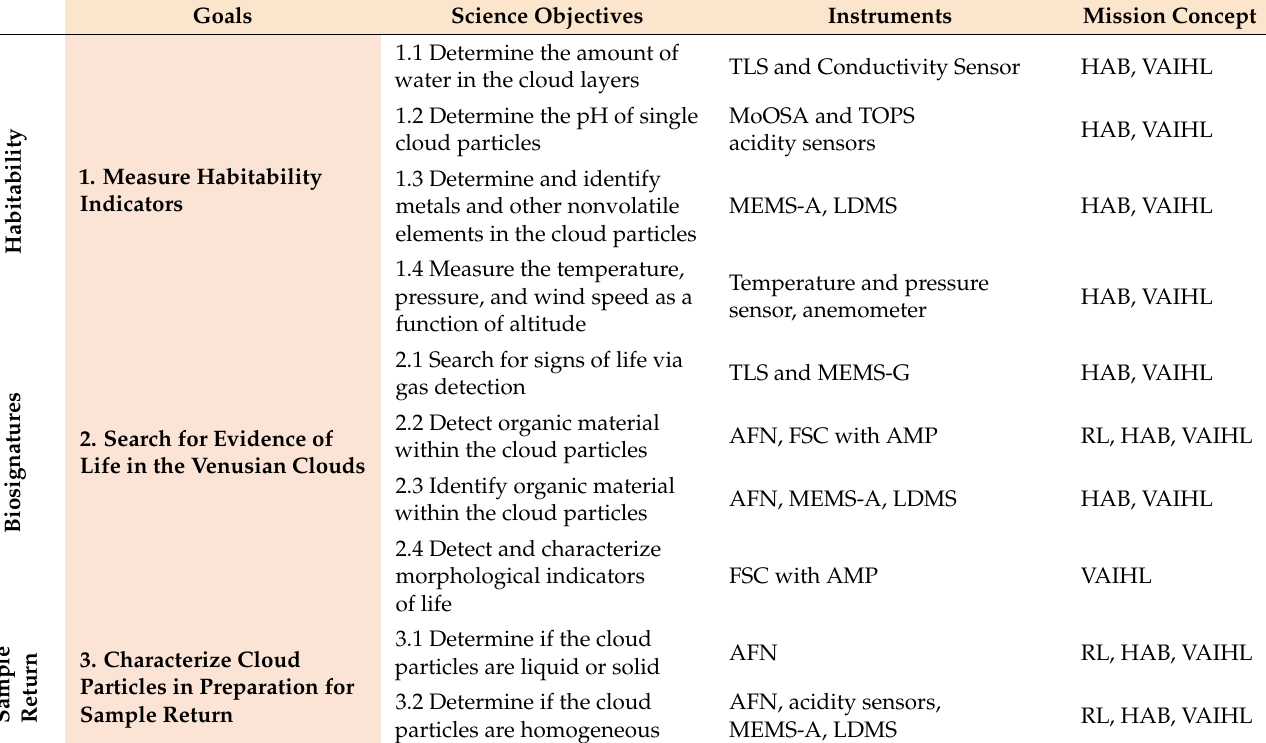
Table 1. Summary of VLF mission concepts, science goals, objectives, and instruments. Instruments: TLS = Tunable Laser Spectrometer, MoOSA = Molybdenum Oxide Sensor Array, TOPS =